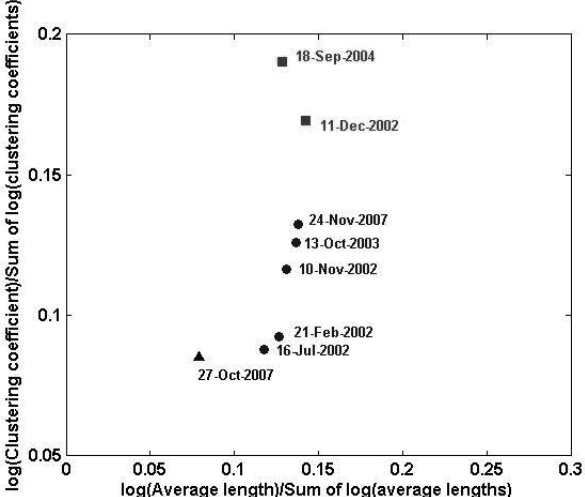
Fig. 3. Classification of the clusters. We see three clusters, one formed by the 27-Oct-2007, other formed by the 18-Sep-2004 and 11-Dec-2002 events, and the remaining. We used the logarithm of the clustering coefficient divided by the sum of the logarithms of the clustering coefficient, and of the logarithm of the average path length divided by the sum of the logarithms of the averaged path lengths.